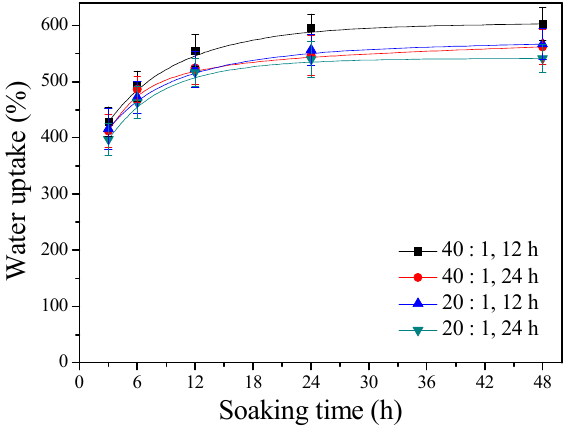
Figure 2. The water uptake capabilities of the γ –PGA/ β –TCP composite fibrous mats.